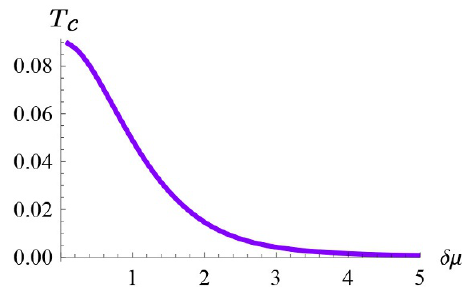
Figure 1. Diagram of critical temperature T c as a function of (cid:14)(cid:22) by considering (2.3) with (cid:11) > 2. (cid:11)